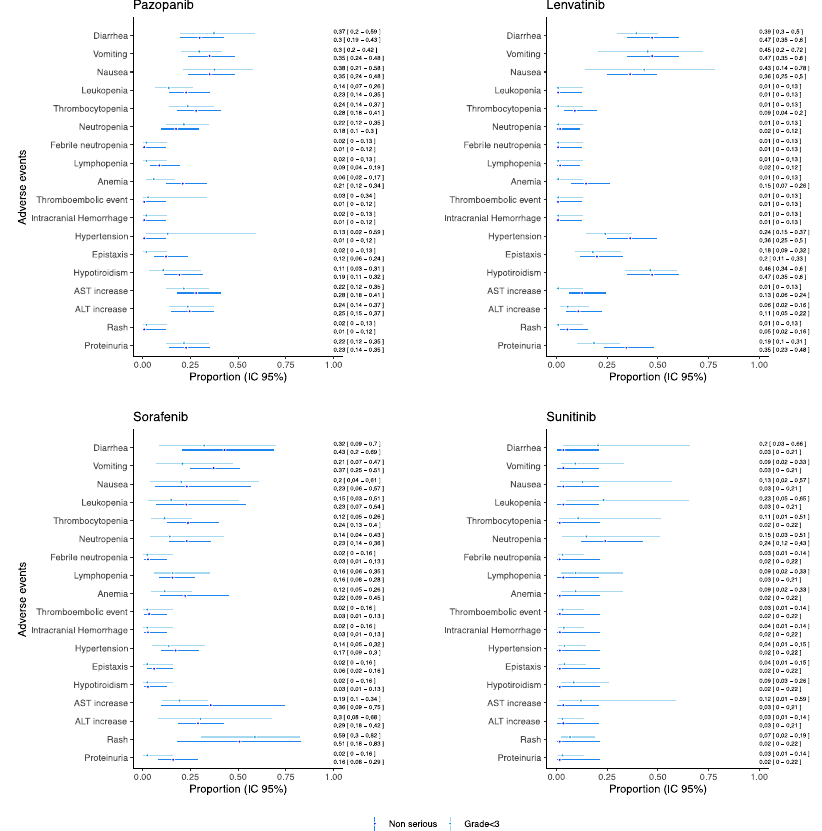
Figure 5. Proportions of non-serious/grade < 3 AEs for pediatric patients receiving anti-angiogenic drugs as monotherapies.